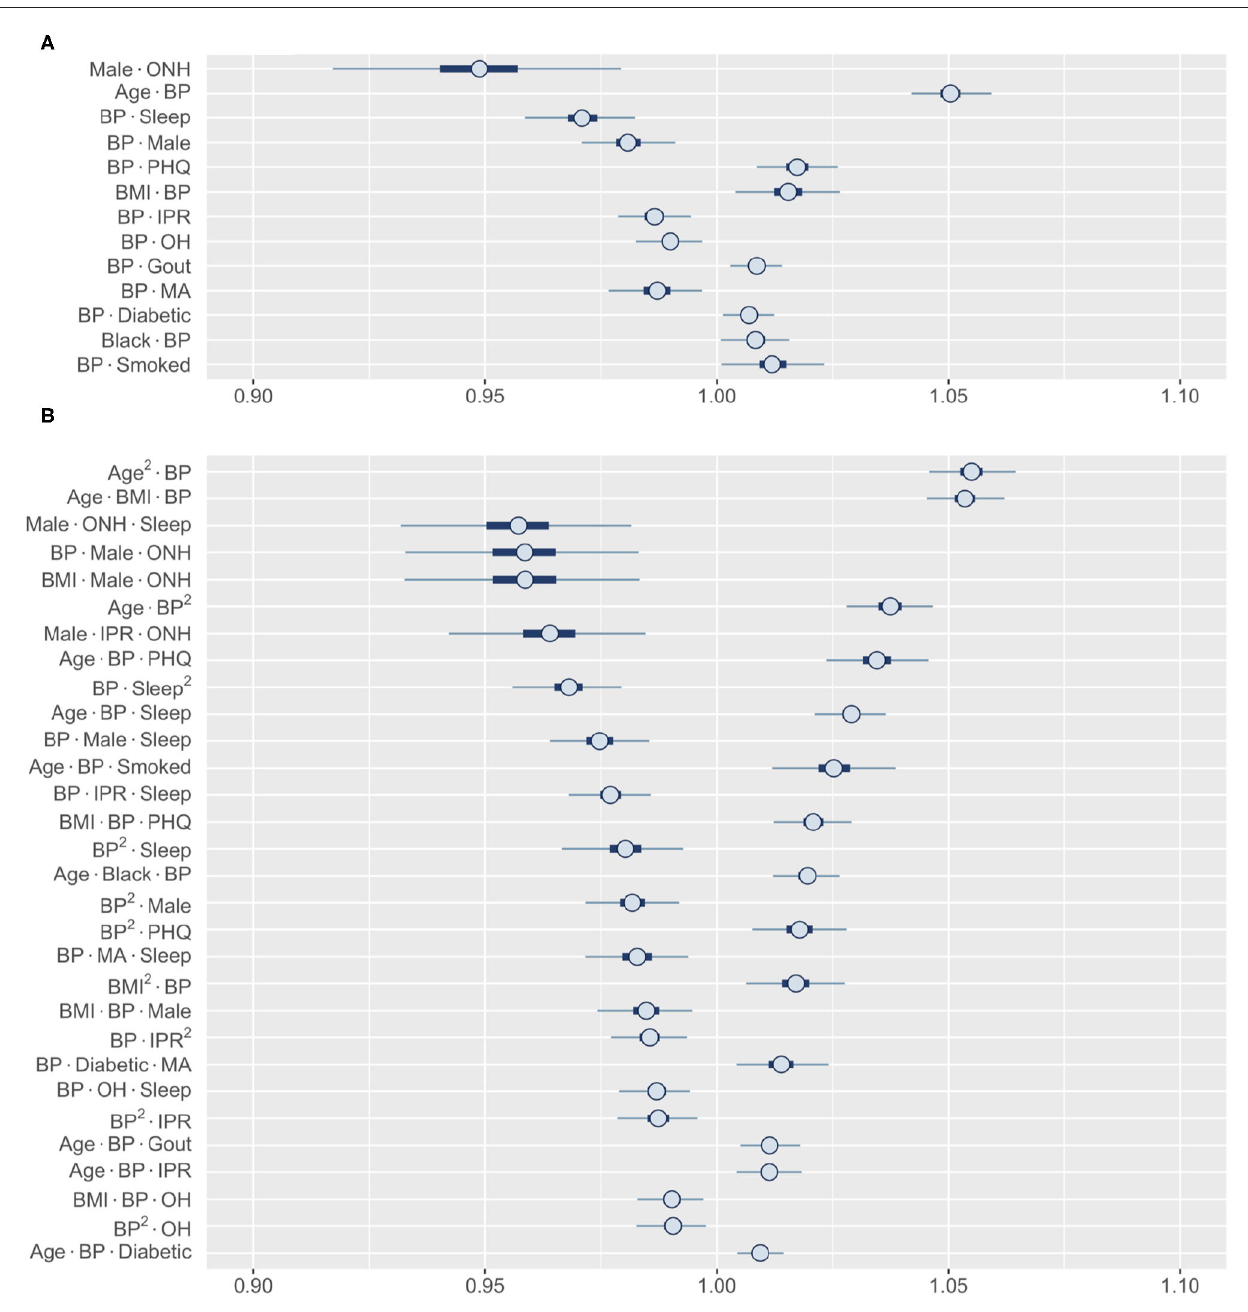
only interaction involving ONH category included in this list (it was also the strongest interaction) is with male gender, strongly lowering the risk for RA. In contrast, the posterior distribution of the interactions of BP indicate that the risk could both increase or decrease depending on the specific interaction. For